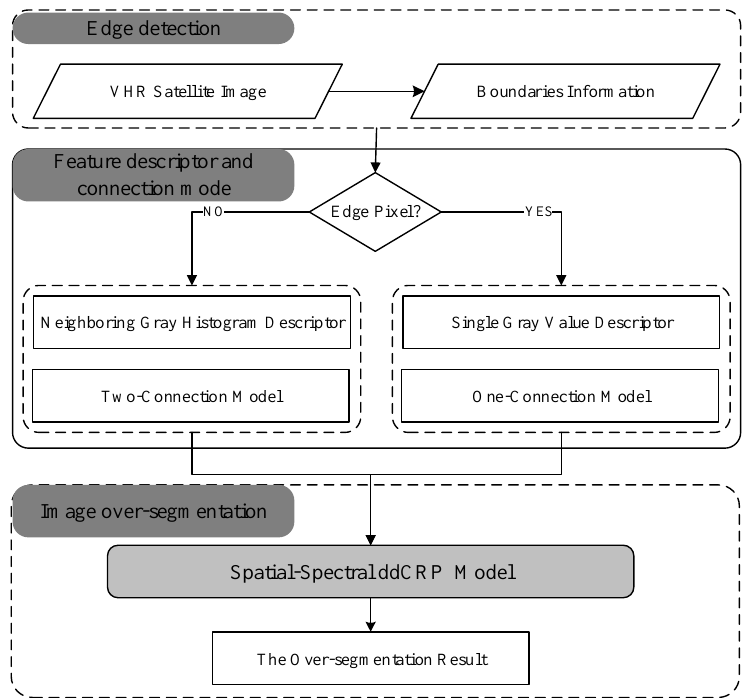
Figure 5. The flowchart of Edge Dependent Chinese Restaurant Process (EDCRP) for image over-segmentation.